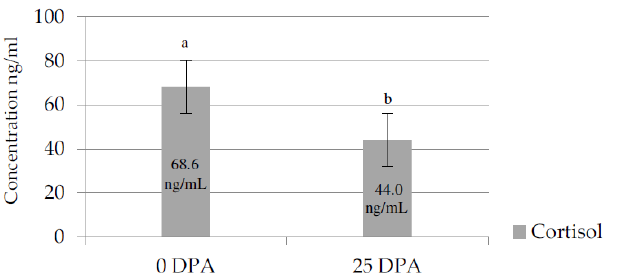
Figure 1. Cortisol serum levels (ng/mL) of heifers at 0 and 25 days